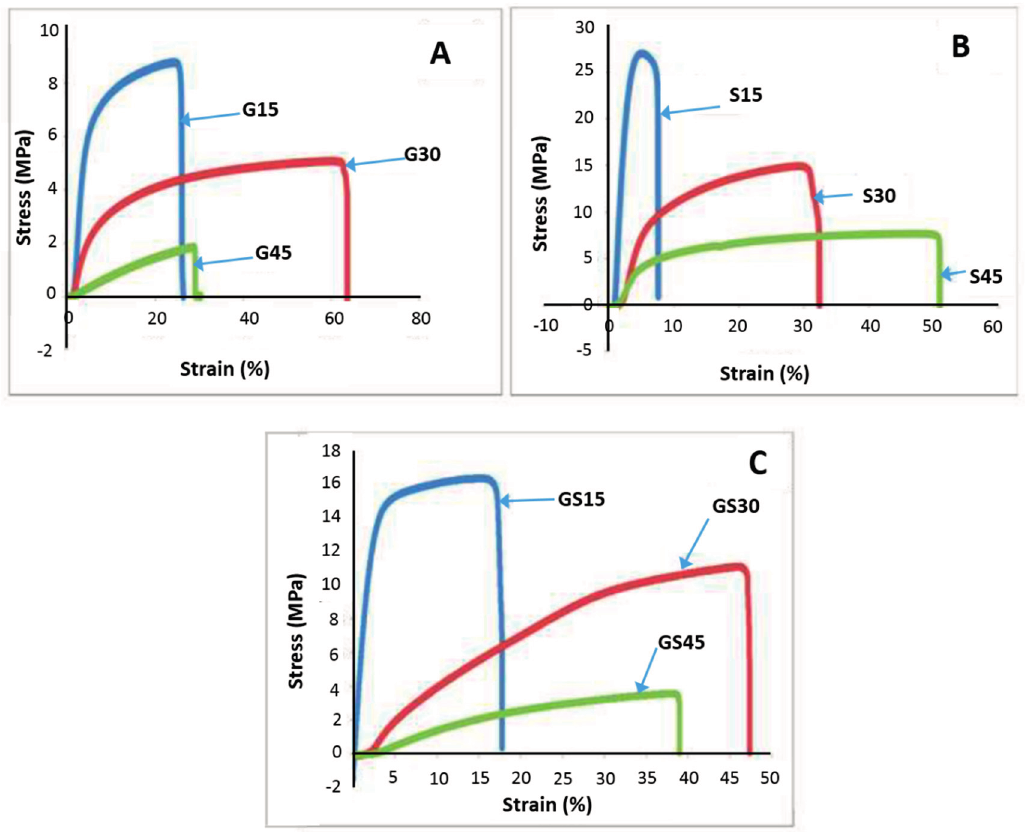
Figure 3. Stress-strain curve graph of ( A ) glycerol (G)-plasticized films; ( B ) sorbitol (S)-plasticized films; and ( C ) glycerol-sorbitol (GS)-plasticized